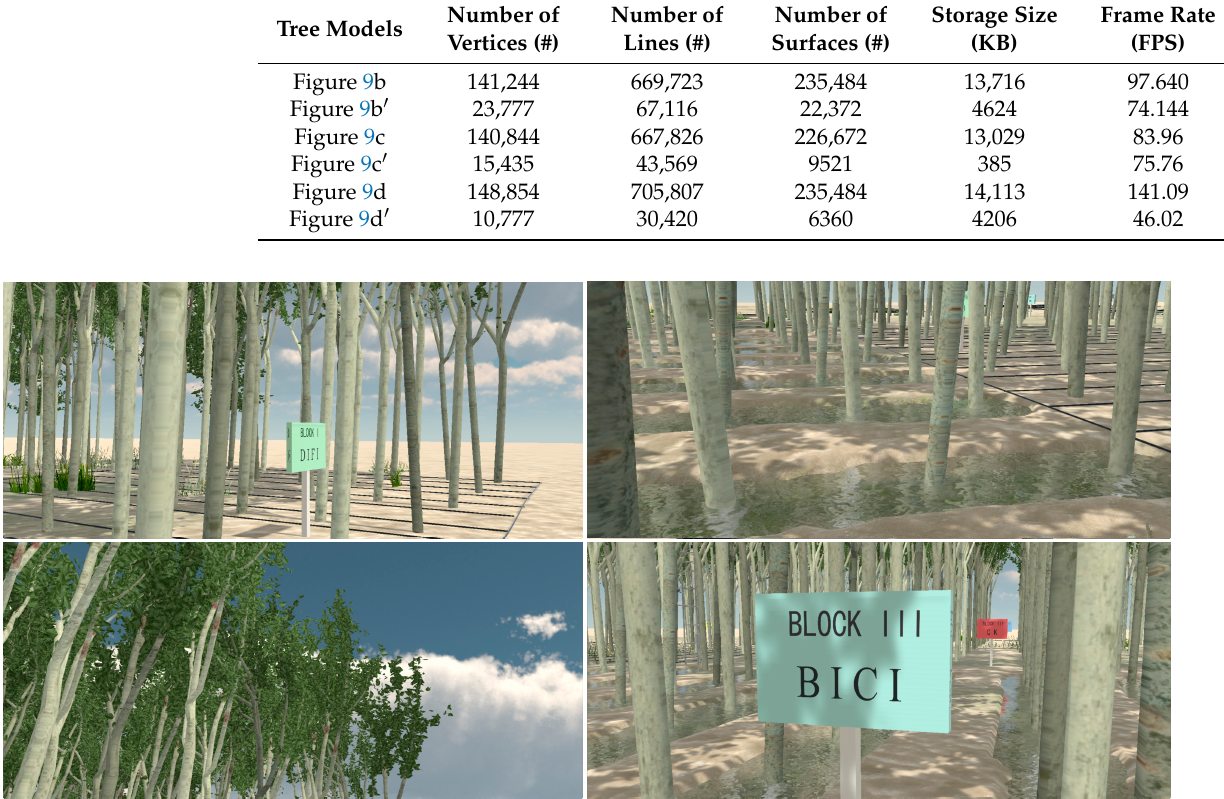
Figure 10. Virtual poplar plantation scene